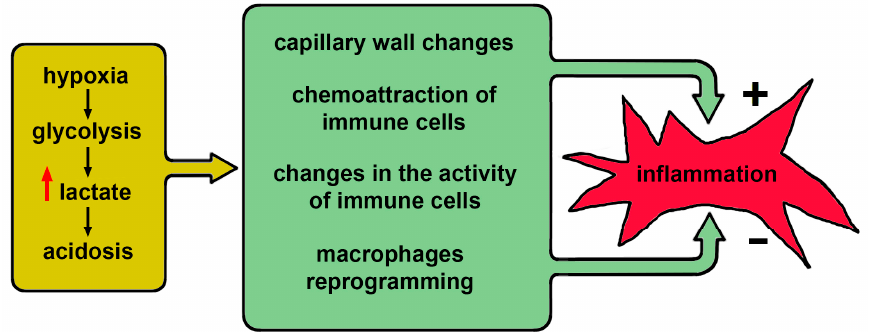
Figure 2. A diagram illustrating the complex relationship between hypoxia and acidosis on the one hand and the development of inflammation.